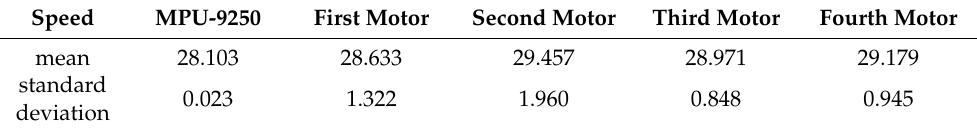
Table 1. The means and standard deviations of the speeds in Figures 6–9 (unit: cm/s).